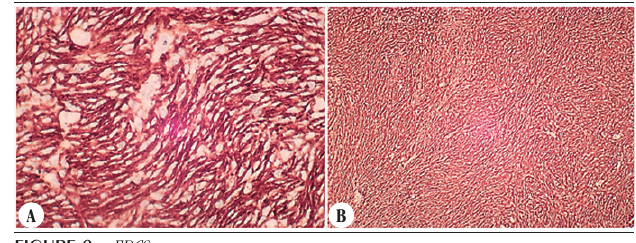
FIguRE 9 − FDCS Immunohistochemical staining shows that this neoplasm is positive for CD21 (A) and CD23 (B). FDCS: follicular dendritic cell sarcoma; CD21: ; CD23: .